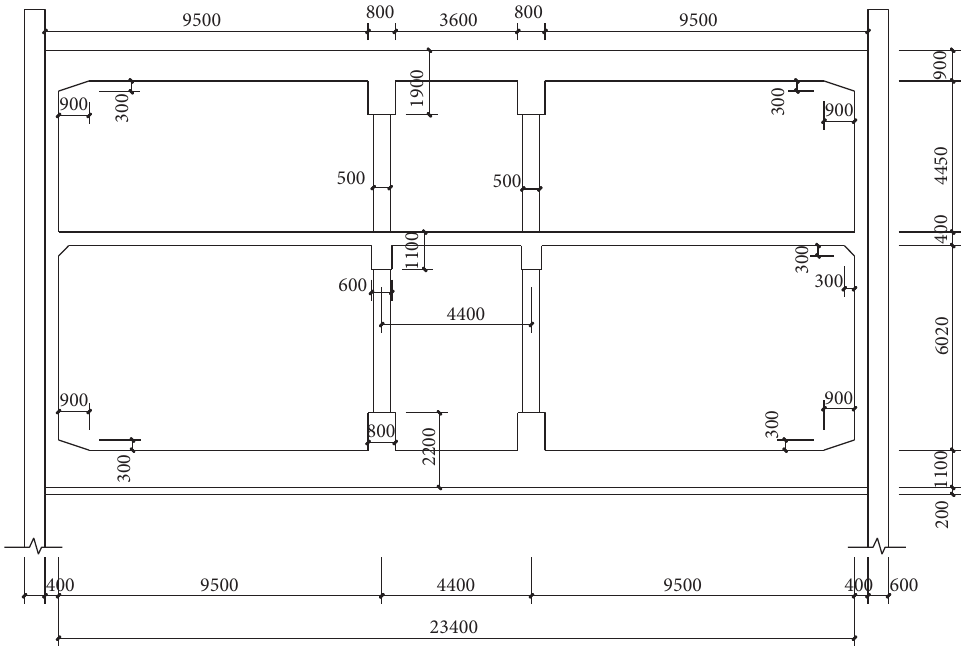
Figure 5: Sectional shape and geometry of two layers and three crosses subway station structure.